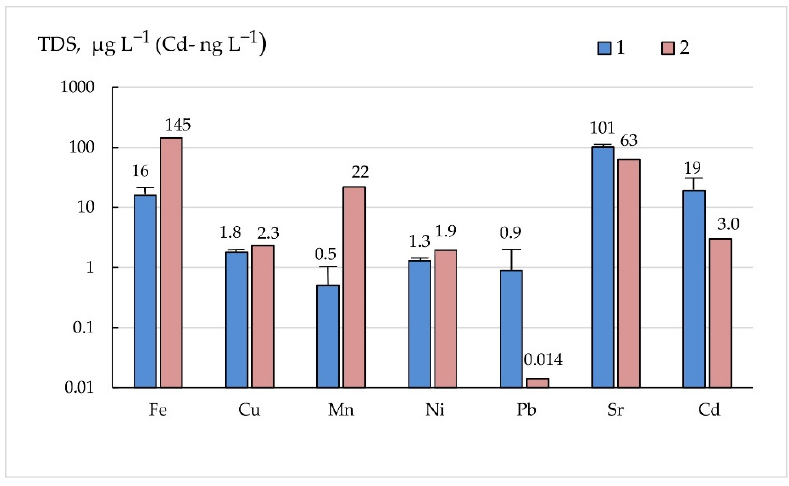
Figure 4. Content of the soluble form of elements in Ob waters: (logarithmic values): 1—the year 2020 autumnal low-water period (our data); 2—Ob River average (data from [22] were used). Error bars represent 1 SD.